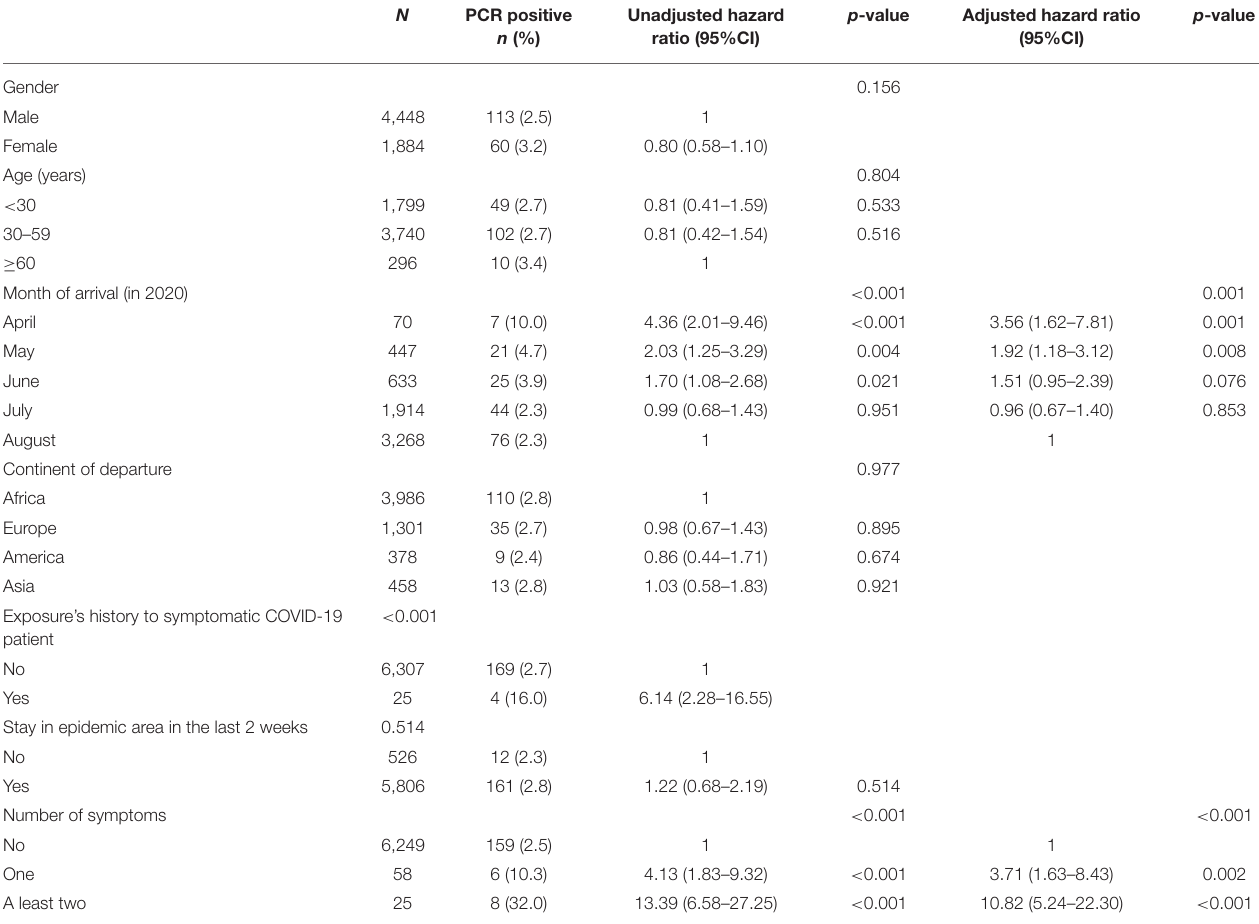
TABLE 2 | Univariate and multivariate analysis of the risk of being